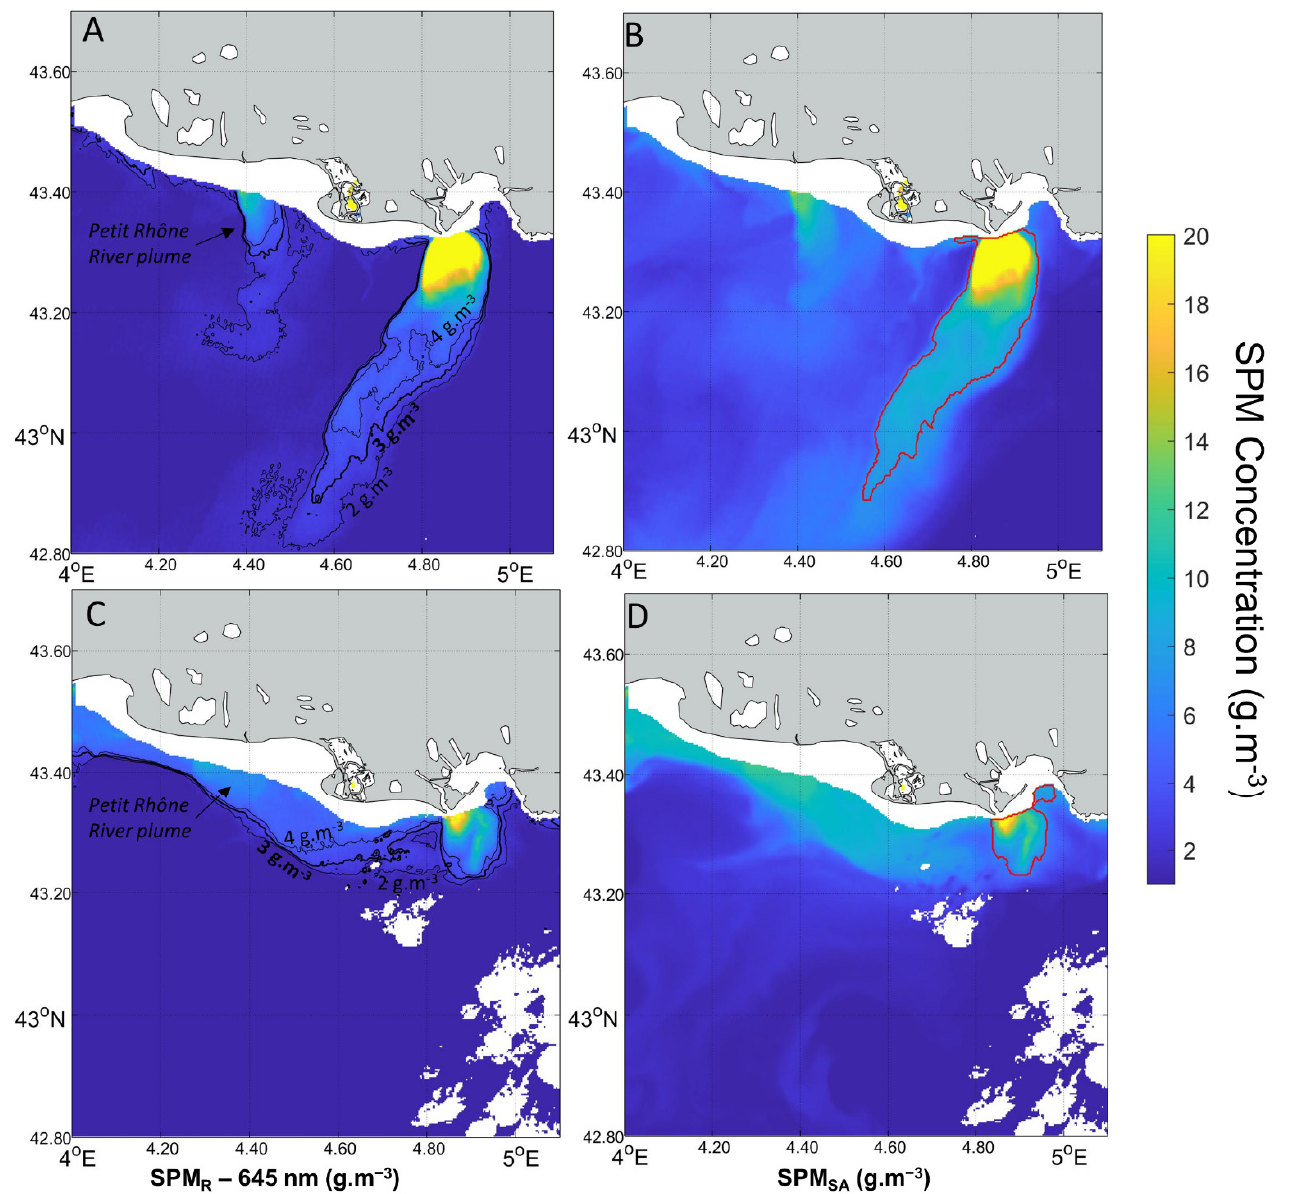
Figure 5. Detection of the Rhône River plume boundaries for two wind conditions: offshore wind on 20 February 2014 ( A , B ) and onshore wind on March 3, 2018 ( C , D ). ( A , B ) MODIS-derived SPM R concentration map with contours corresponding to SPM R concentrations of 2, 3, and 4 g.m − 3 . The threshold of 3 g.m − 3 (coarse line) is selected to delimitate the plume contour while the thresholds of 2 and 4 g.m − 3 (thin lines) are used to evaluate the uncertainties on the derived Rhône River plume area and SPM mass due to the choice of the threshold. ( B , C ) Final plume contour (3 g.m − 3 ) superimposed on the SPM SA concentration map. For ( D ), the final contour was allowed to slightly contract toward the threshold of 4 g.m − 3 in order to better isolate the Grand Rhône River plume from the Petit Rhône River plume. White areas along the coast correspond to shallow waters with depths lower than 20 m.